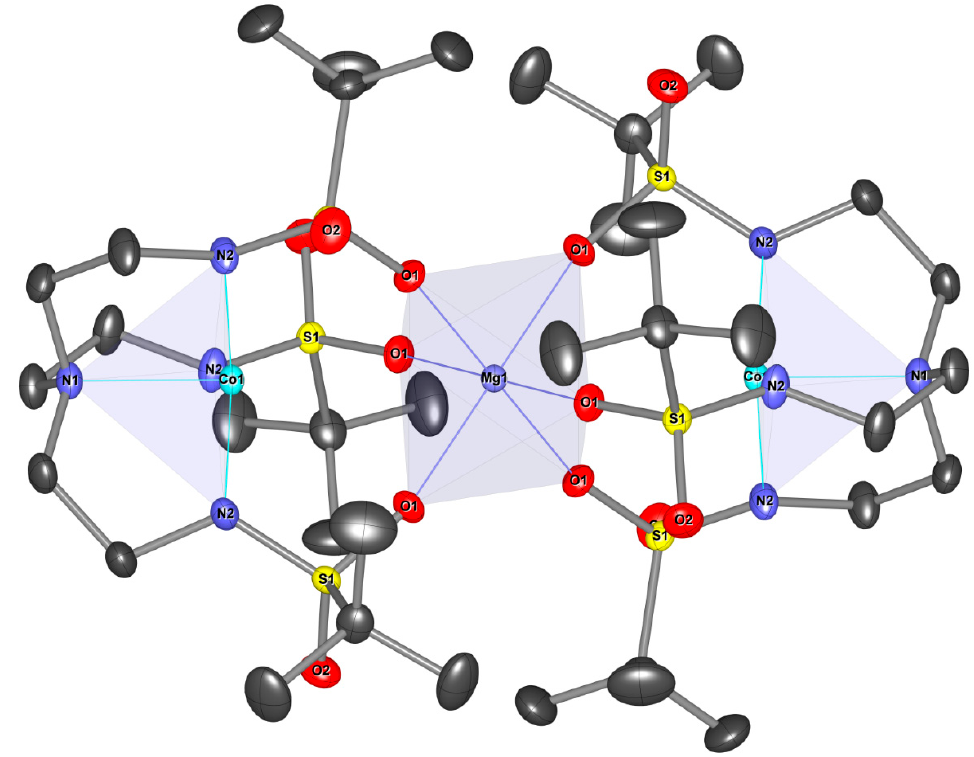
Figure 1. Thermal ellipsoid plot of the dimeric Co 2+ complex, [(Co(Ts 3 tren))Mg(Co(Ts 3 tren))]. Thermal ellipsoids are shown at the 79% probability level.